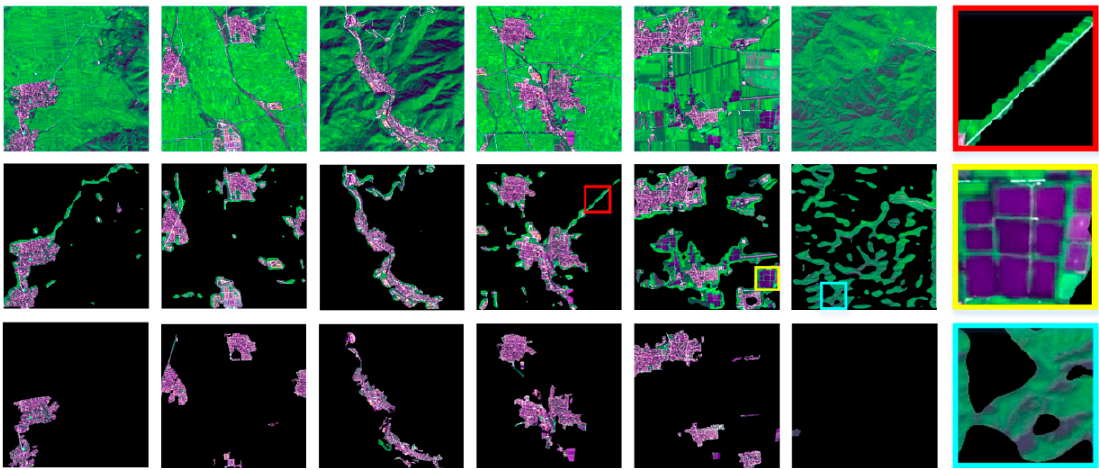
Figure 1. An example illustrating JMS’s merits. Top : a set of images sharing similarities in spectral and texture. Middle : ROIs detected by a single-image saliency detector, FDA-SRD. Bottom : ROIs based on JMS analysis; Last column : the enlarged view for roads, reservoir, and shadow.